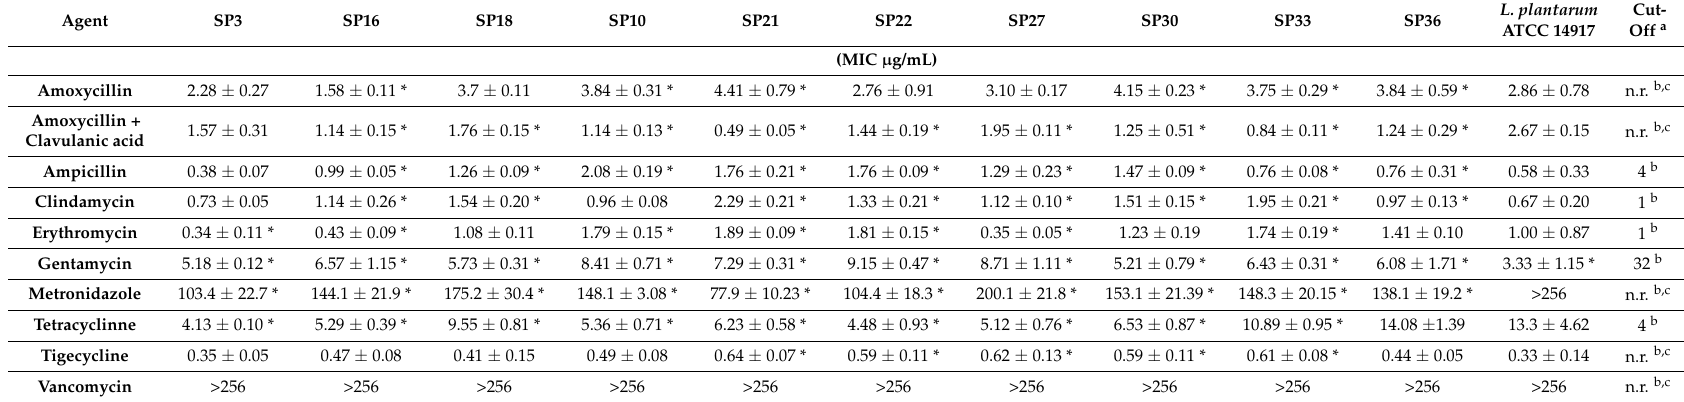
* Denotes a statistically significant difference in MIC values between the corresponding and the reference strain ( L. plantarum ATCC 14971). a Breakpoints are referred to L. casei/paracasei strains. EFSA breakpoints for other types of LABs are slightly different. b Strains with MIC higher than the breakpoints are considered as resistant according to EFSA. c not